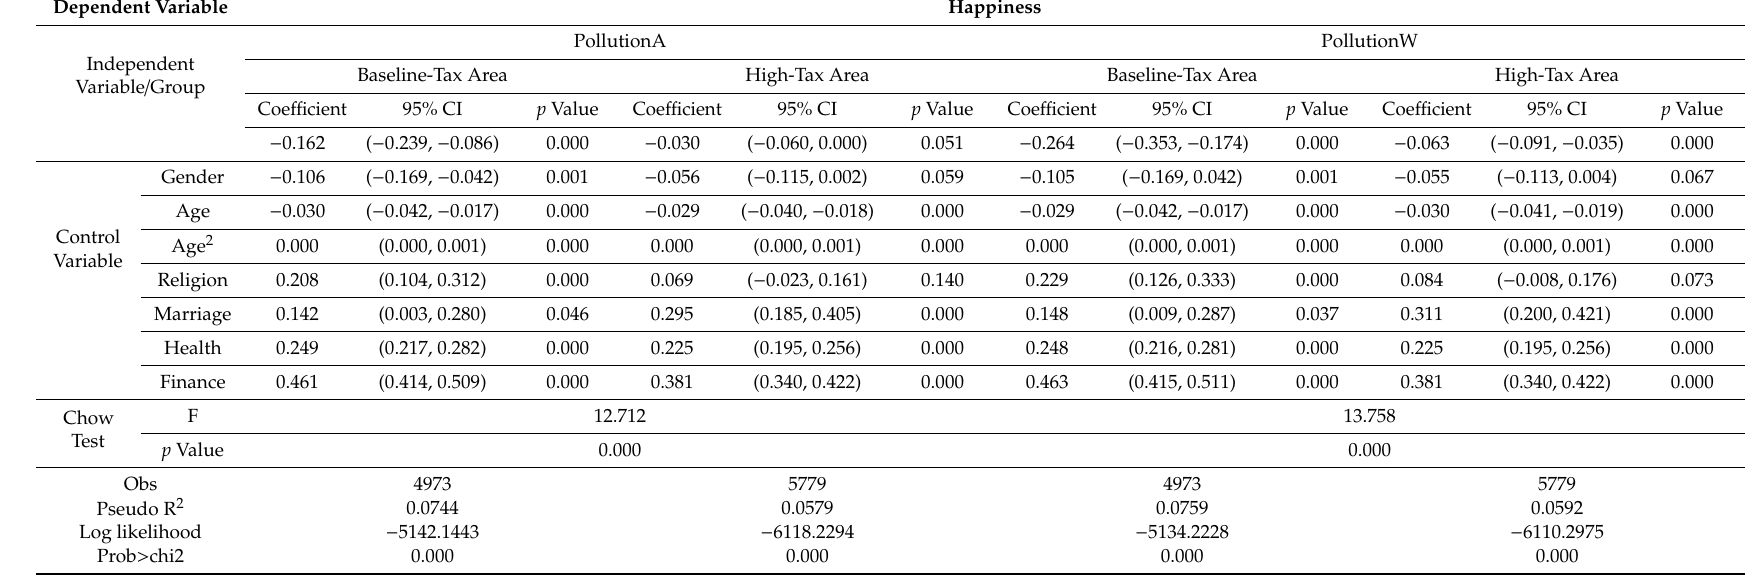
Table 4. Environmental tax moderator e ff ect test